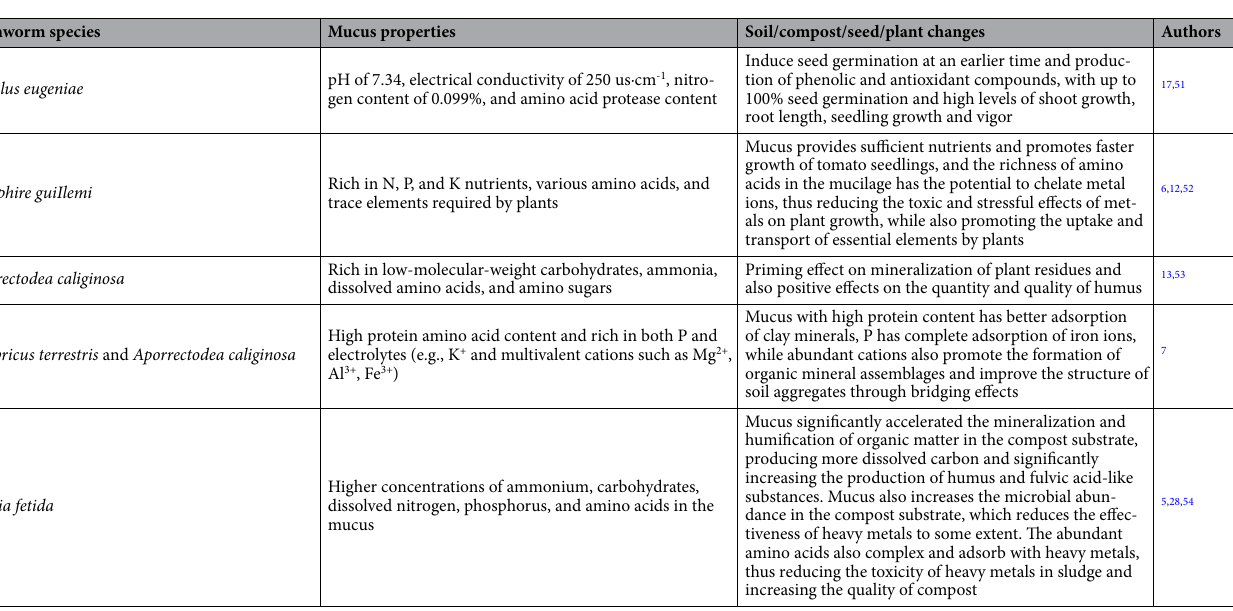
Table 2. Properties and ecological functions of earthworm